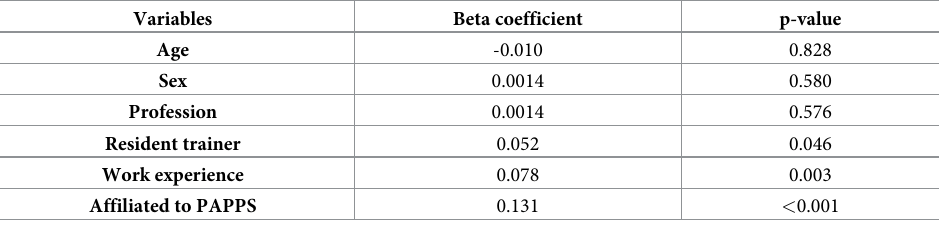
Table 3. Knowledge of PC professionals on PAPPS recommendations according to socio-demographic and occu- pational